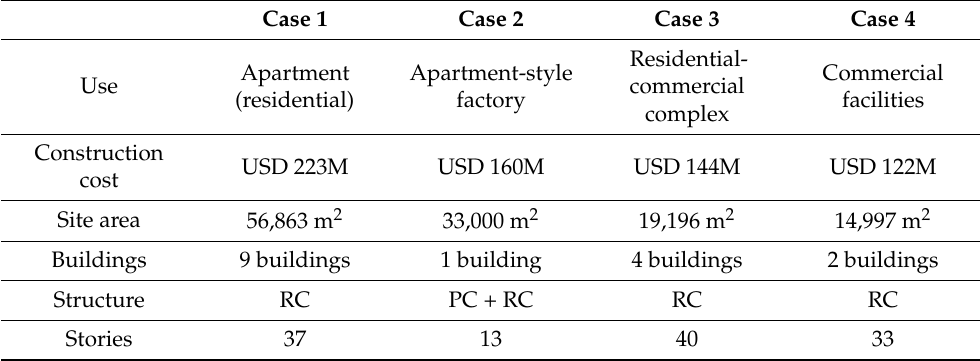
Table 7. Project profiles used in validation